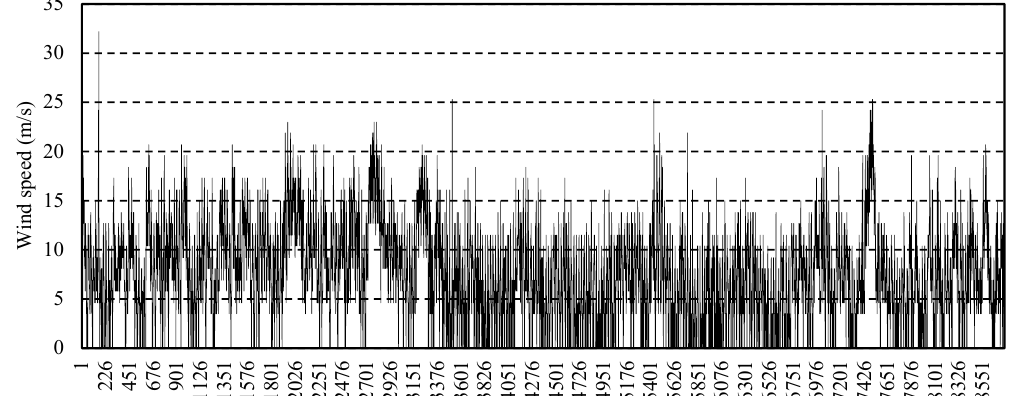
Mathematics 2020 , 8 , x FOR PEER REVIEW